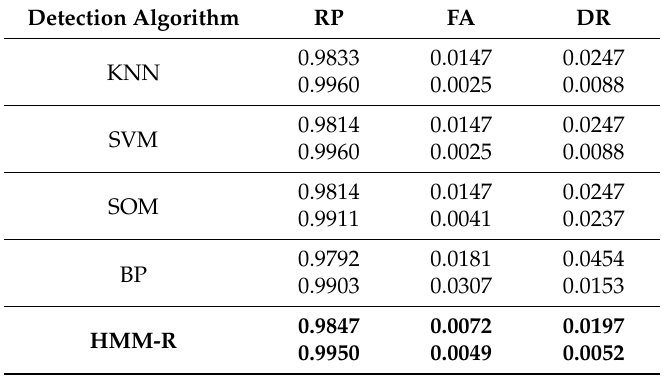
Table 5. Performance of algorithms with attack ratio of 0.25 and 2.5 in window